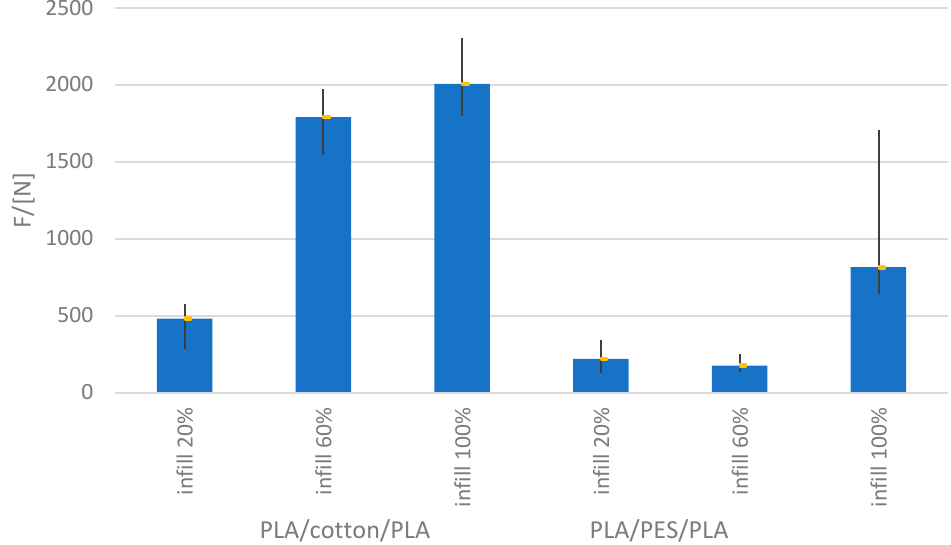
Figure 3. Test results of the breaking strength of PLA/cotton/PLA and PLA/polyester/PLA with fillings of 20, 60 and 100%.